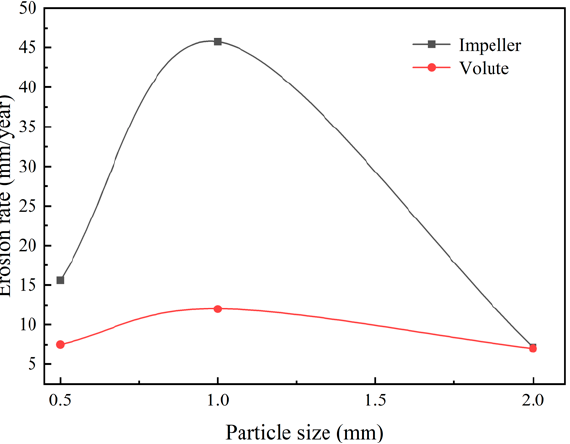
Figure 14. Maximum erosion rates on different components of the pump with particles of different sizes.